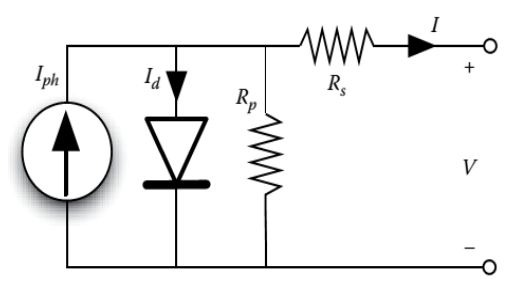
Fig. 1: One diode